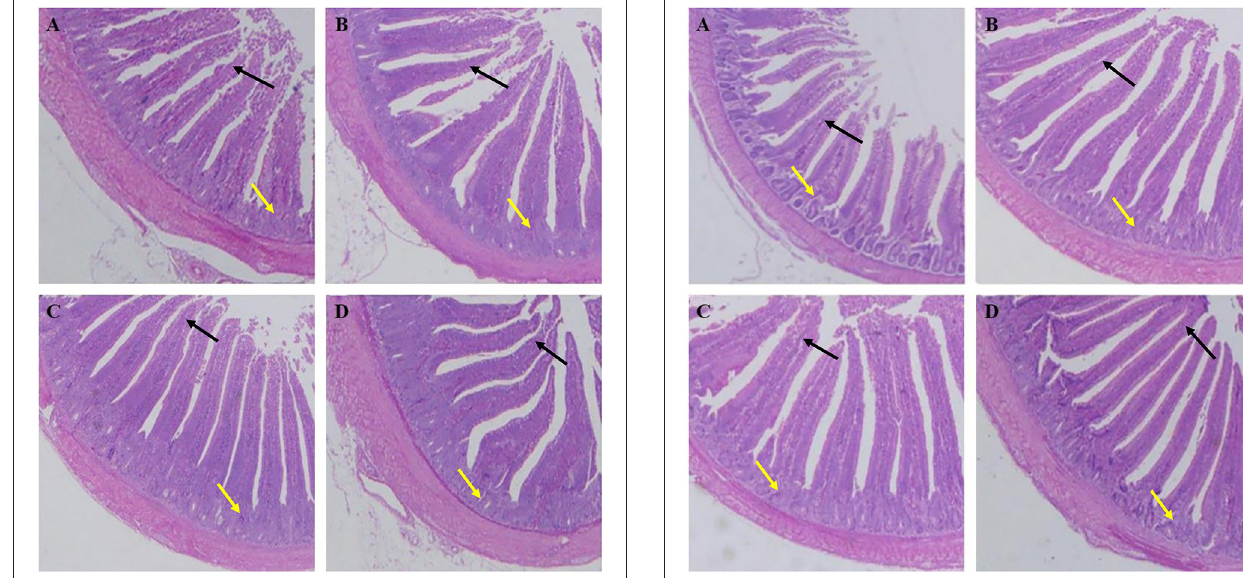
FIGURE 2 | Dietary plectasin increased the jejunum length while decreased crype depth of 21-day-old yellow-feathered chickens. (A) The jejunum of basal diet group, (B) The jejunum of basal diet plus 10mg enramycin/kg, (C) The jejunum of basal diet plus 100 mg/kg plectasin, (D) The jejunum of basal diet plus 200 mg/kg plectasin. Black arrow shows the villus length, and yellow arrow shows the crypt depth. For histological observation, image at 40 were